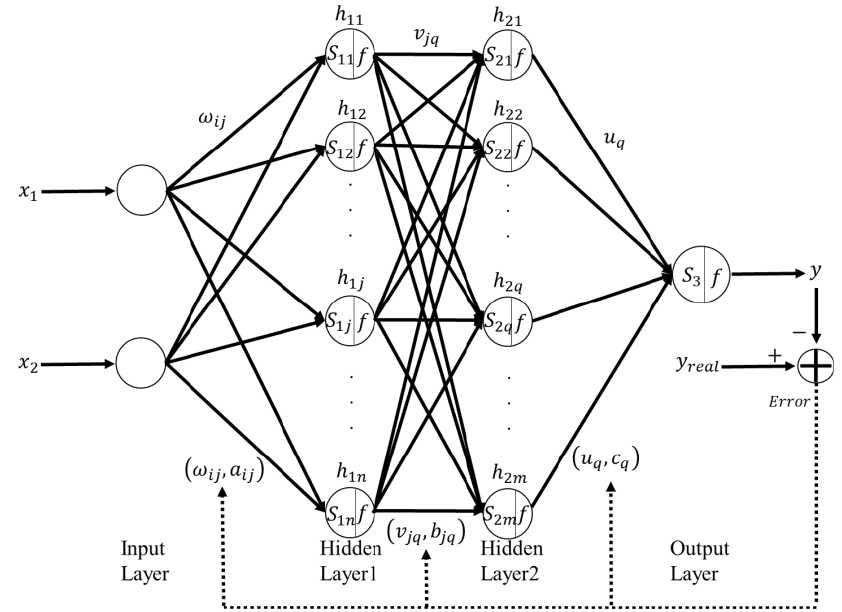
Figure 3. Framework of deep neural network.